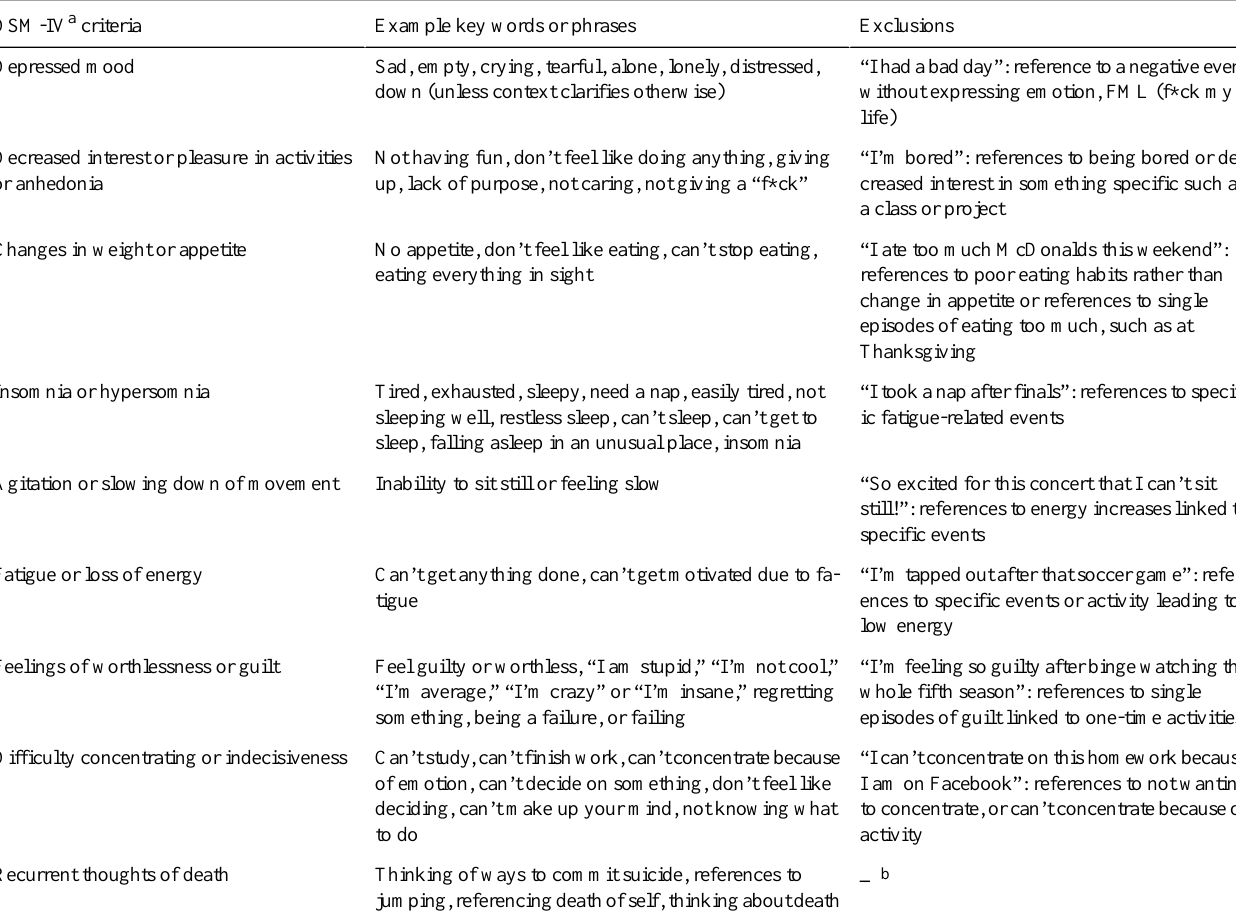
Table 1. Depression symptom definitions applied to Facebook profile status updates.